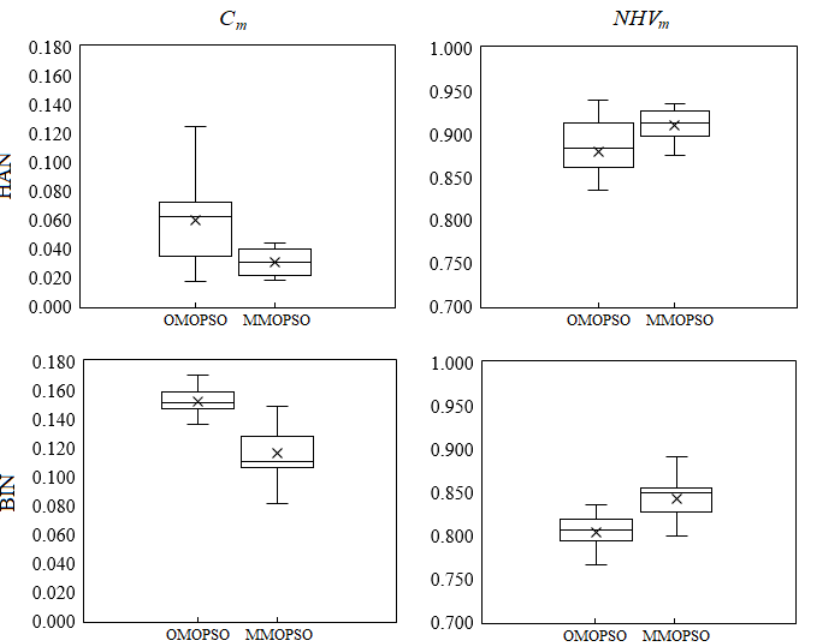
Figure 3. Box and whiskers plot for C m and NHV m values of 15 runs for OMOPSO and MMOPSO in each